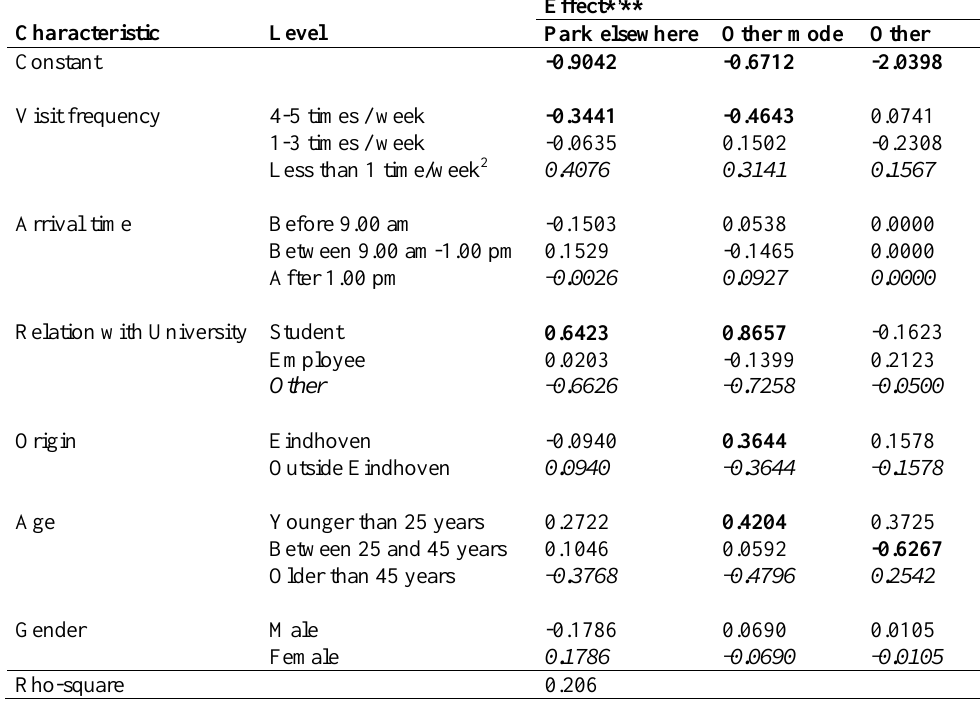
Table 4. Effects on behavioral response to restricted access by